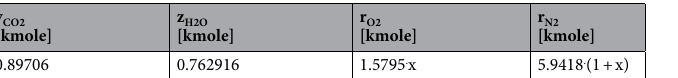
Table 5. The mole composition in the flow section ”1”. Where y CO2 = n CO + n CH4 + 2 n C2H4 + 2 n C2H6 + 3 n C3H6 + 3 n